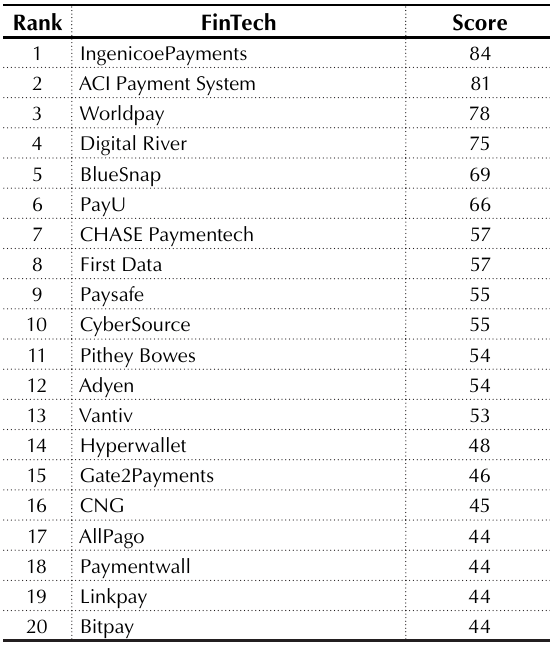
Table 3. The ranking of the most successful FinTech in cross-border payments